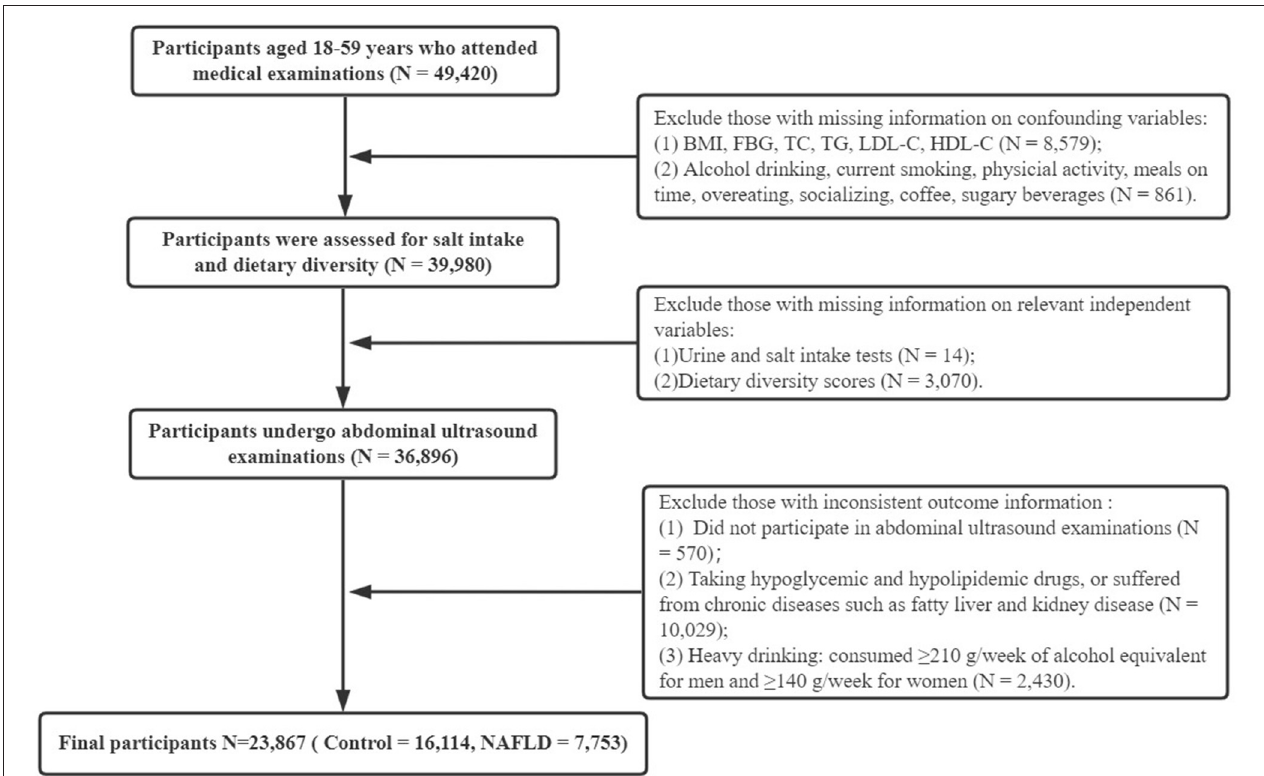
FIGURE 1 | Flowchart of the study. BMI, body mass index; FBG, fasting blood glucose; TC, total cholesterol; TG, triglycerides; LDL-C, low-density lipoprotein cholesterol; HDL-C, high-density lipoprotein cholesterol; NAFLD, non-alcoholic fatty liver disease.